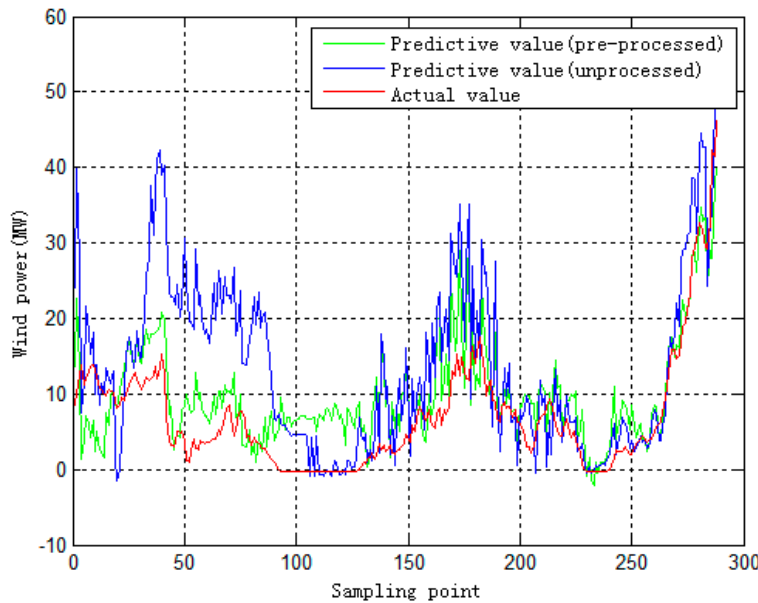
Figure 10. The comparison between the predictive values and the actual values.